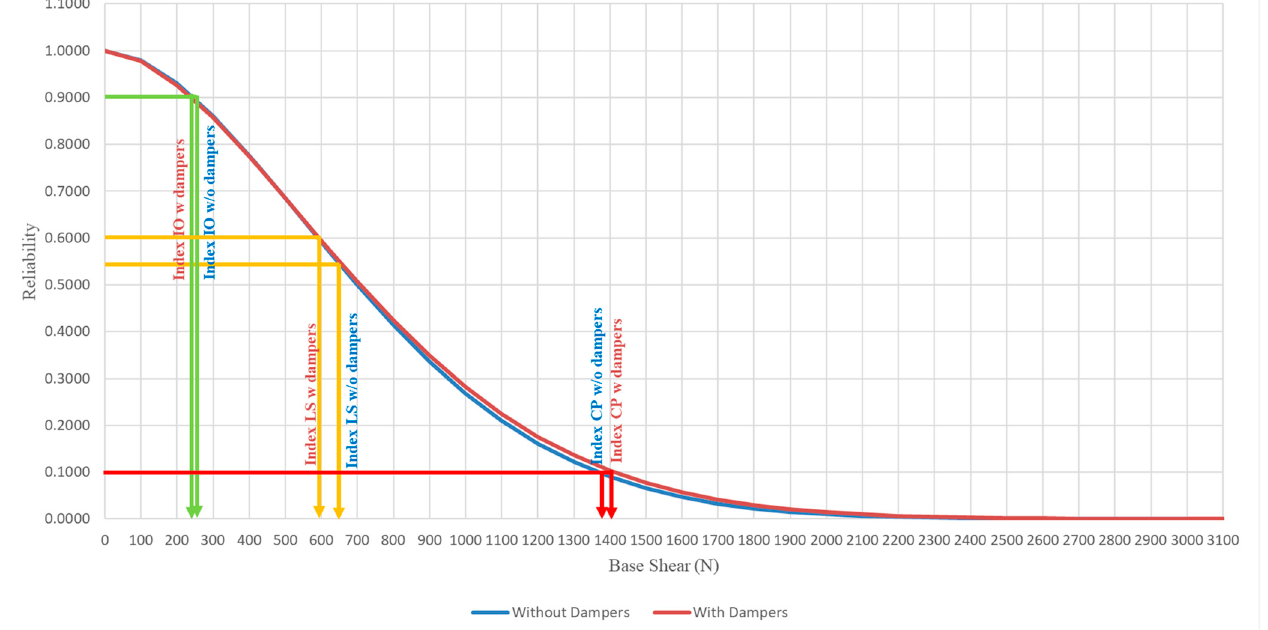
Figure 13. Reliability plot for structures with and without dampers attached to the base storey.